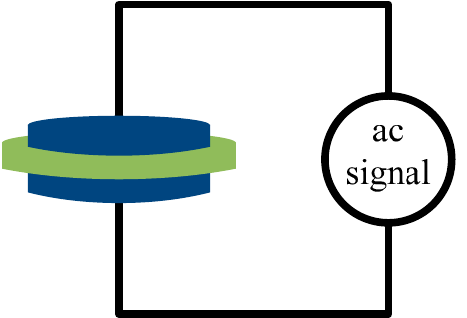
Figure 8. Schematic diagram for electrochemical stability measurement.